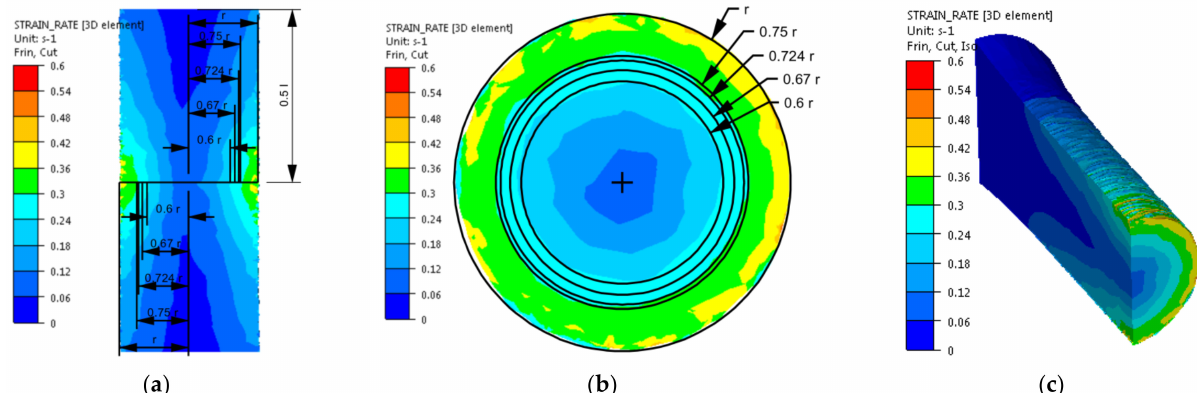
Figure 12. Distribution of the strain rate intensity of the 5019 aluminium alloy calculated numerically using coefficients from Table 2: ( a ) longitudinal section, ( b ) cross-section—centre of the working part and ( c ) perspective.